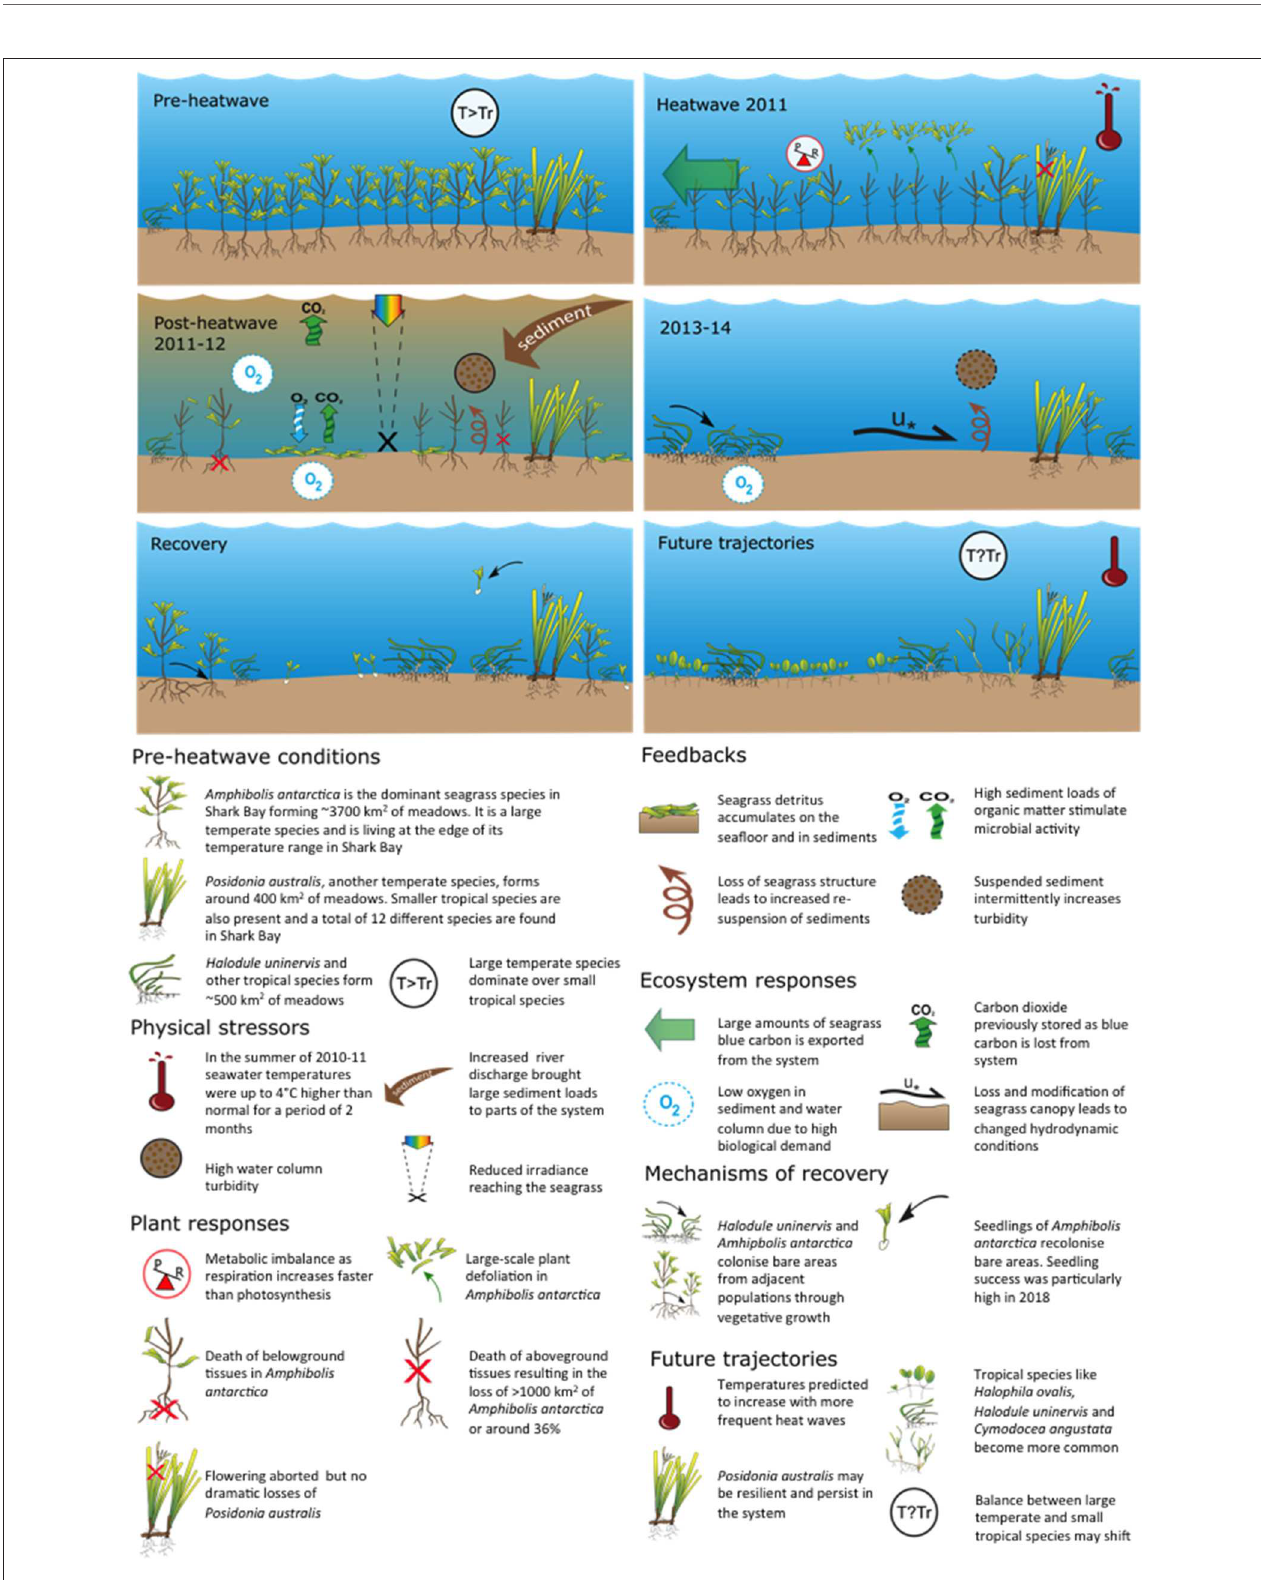
FIGURE 7 | Generalized timeline of change in seagrass structure and composition before during and after the 2011 MHW with potential future shown (Data and publications shown in Table S1 ).